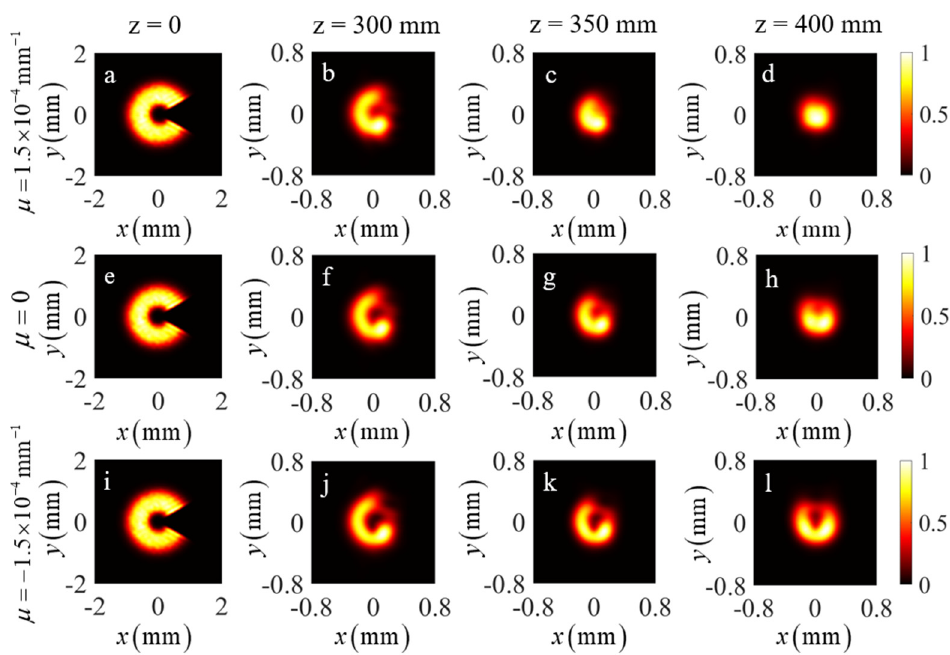
Figure 10. The experimental results for the averaged intensity at different propagation distances of the generated TLGSM beam with ( a – d ) the twist factor µ = 1.5 × 10 − 4 mm − 1 , ( e – h ) µ = 0, and ( i – l ) µ = − 1.5 × 10 − 4 mm − 1 . The TLGSM beam is obstructed by a sector-shaped opaque